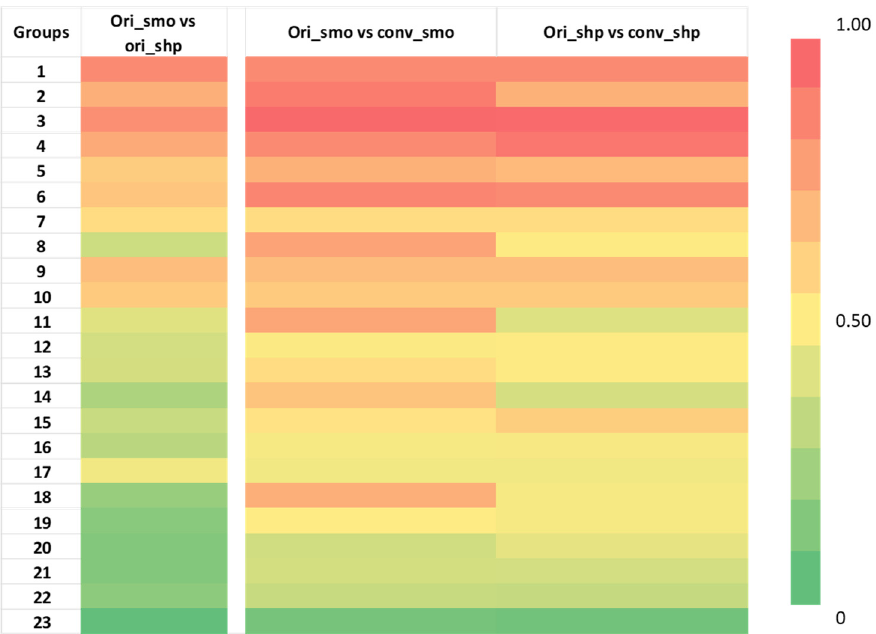
Figure 3. Heatmap of concordance correlation coefficient (CCC) of 87 radiomic features from de- velopment cohort divided into 23 groups as previously done for comparison [19]. Red represents a CCC value of 1, which means perfectly reproducible, while green represents a CCC value of 0, which means not reproducible. There is an increase in CCC after the kernel conversion in multiple feature groups. The names of the features within each group are indicated in Supplementary Materials Table 3. The numerical values can be found in Supplementary Materials Table S4. Table 2. Development cohort’s average and median reproducibility values calculated in CCC. The Wilcoxon matched-pairs signed ranks test results are shown for (ori_smo vs. ori_shp) group against (ori_smo vs. conv_smo) group and (ori_smo vs. ori_shp) group against (ori_shp vs. conv_shp) group. Ori_smo vs. Ori_smo Ori_smo vs. Ori_shp